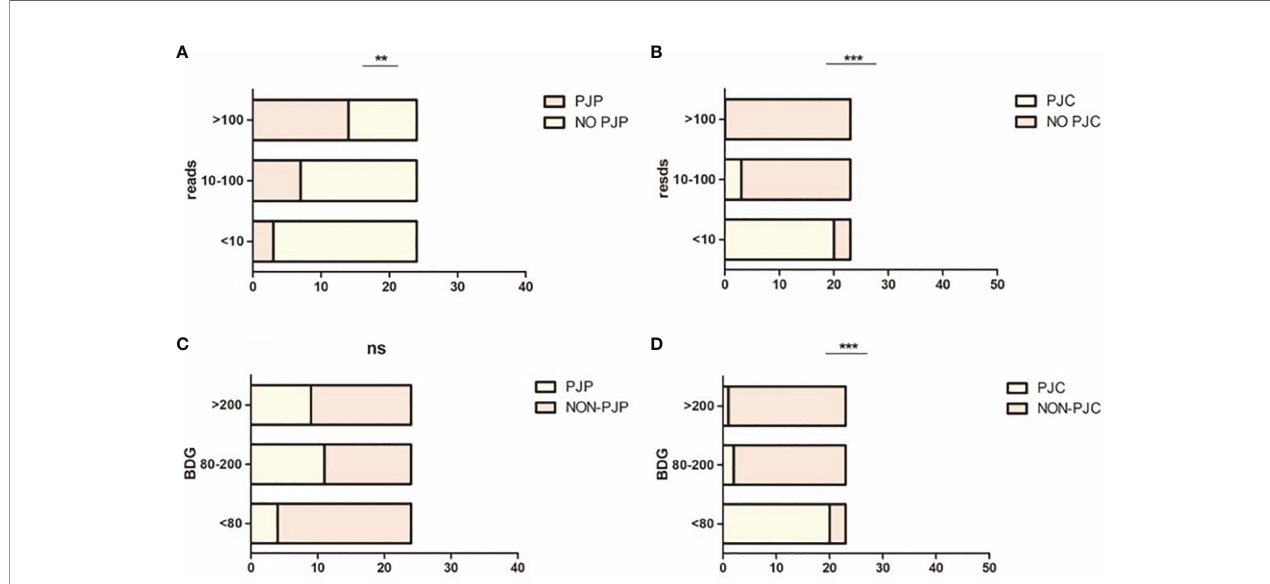
FIGURE 3 | Proportion of Pneumocystis jirovecii pneumonia (PJP) and Pneumocystis jirovecii colonisation (PJC) in different metagenomic next-generation sequencing (mNGS) reads and 1,3- b -D-glucan (BDG) titre. (A) Proportion of PJP in different mNGS reads. (B) Proportion of PJC in different mNGS reads. (C) Proportion of PJP in different BDG titre. (D) Proportion of PJC in different BDG titre. **P = 0.003; ***P < 0.0008; ns P =